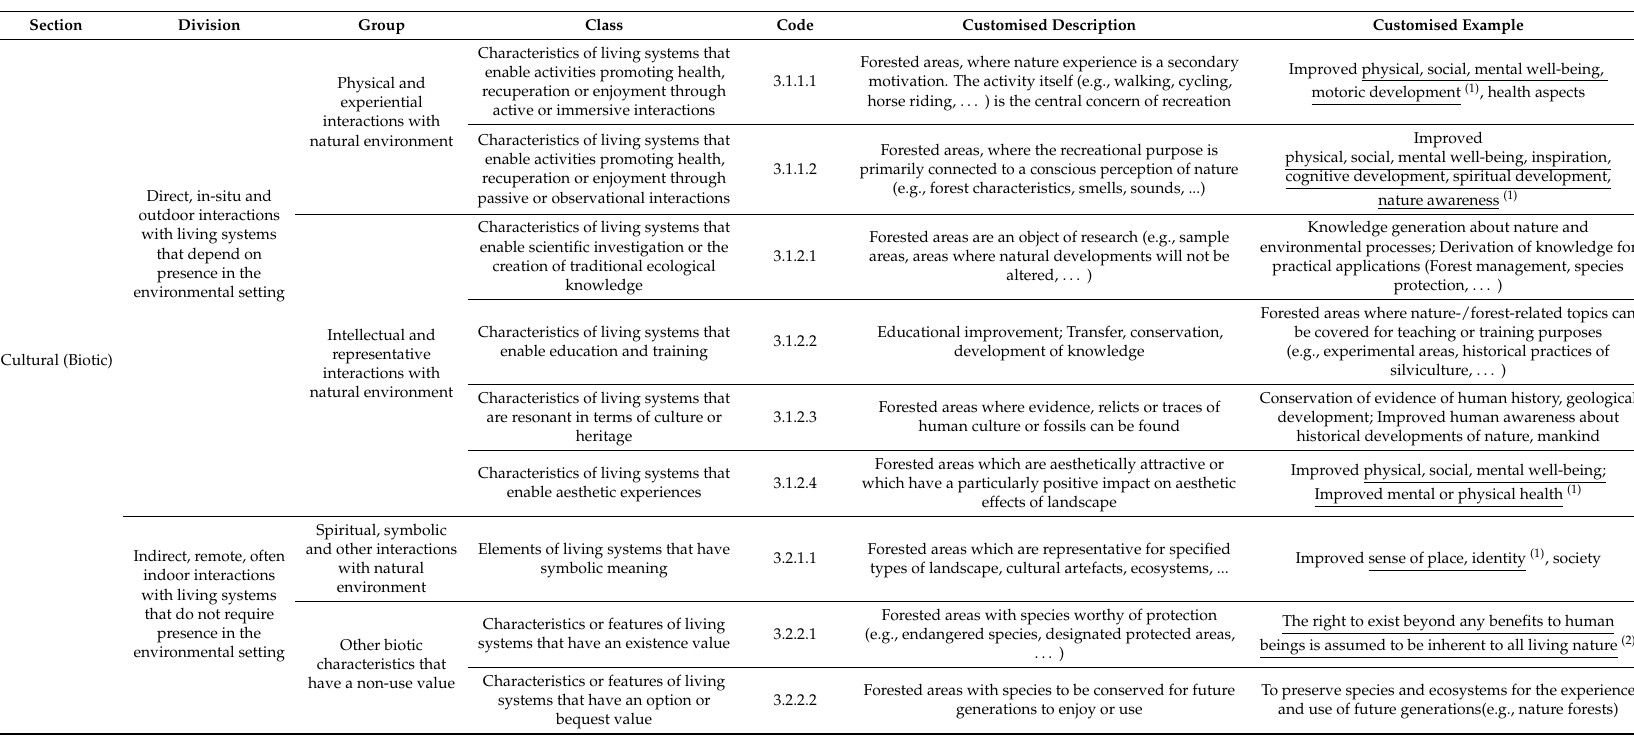
Table 5. Customised CICES Framework for cultural services (biotic). Source: own representation. Underlined text is inspired by (1) [43] and (2) [30].